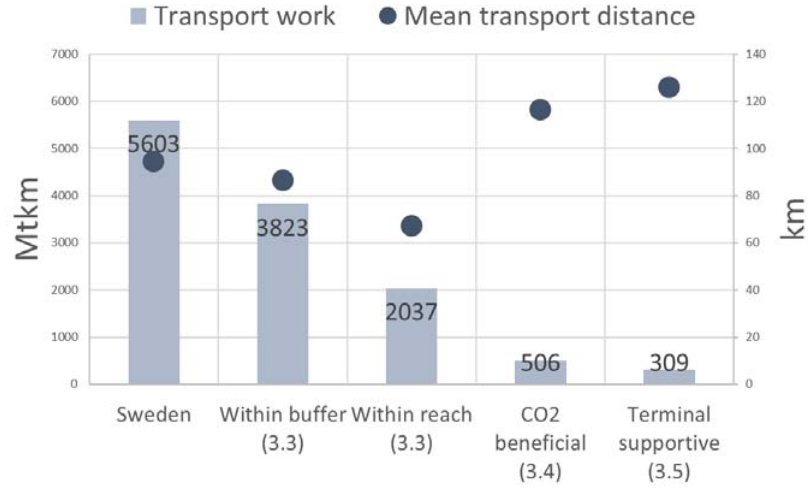
Figure 6. Transport work and mean transport distance for roundwood transport in the different stages of the study.